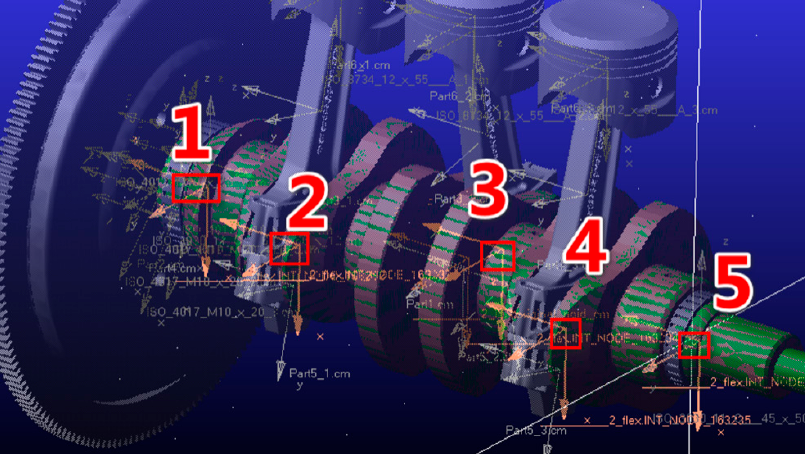
Figure 9. Rigid point se tt ing of the fl exible body.